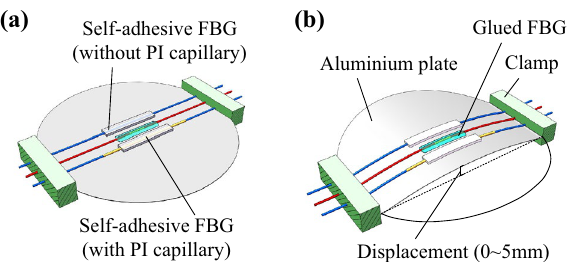
Figure 9. Characterisation of the residual strain transferred to the PDMS-packaged FBG sensors (with and without PI capillary). ( a ) Description of the experiment with an aluminium plate at an initial straight position, and ( b ) after bending the